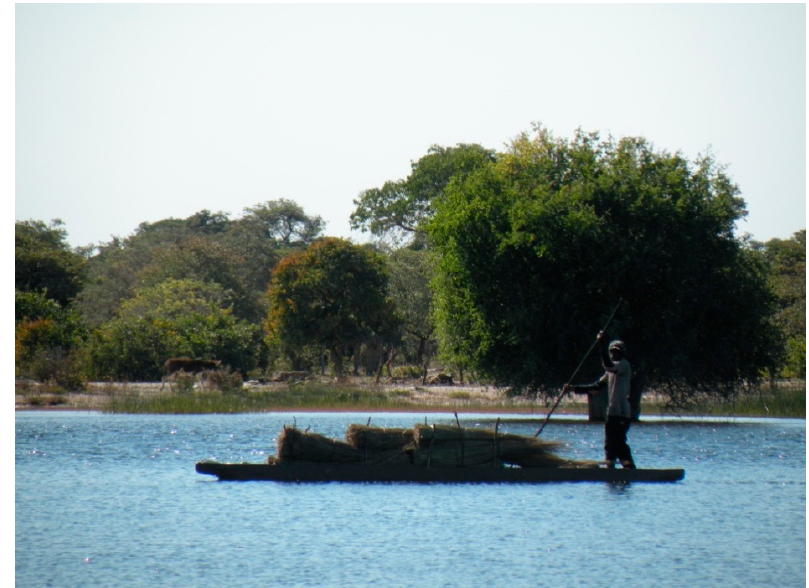
Figure 3. Transporting reeds by mokoro , a traditional dugout canoe, in Etsha 13. Credit: Brian King.